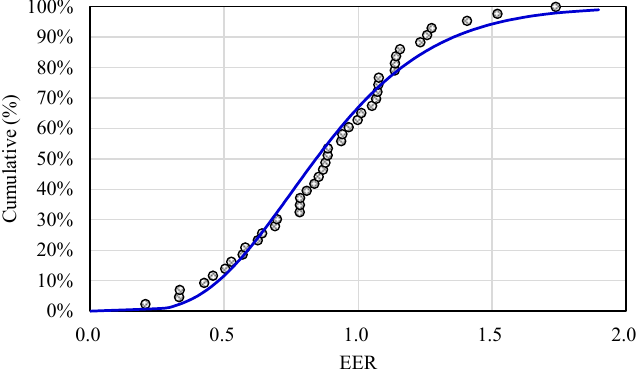
Figure 7. Gamma distribution of EER for Hospitals.